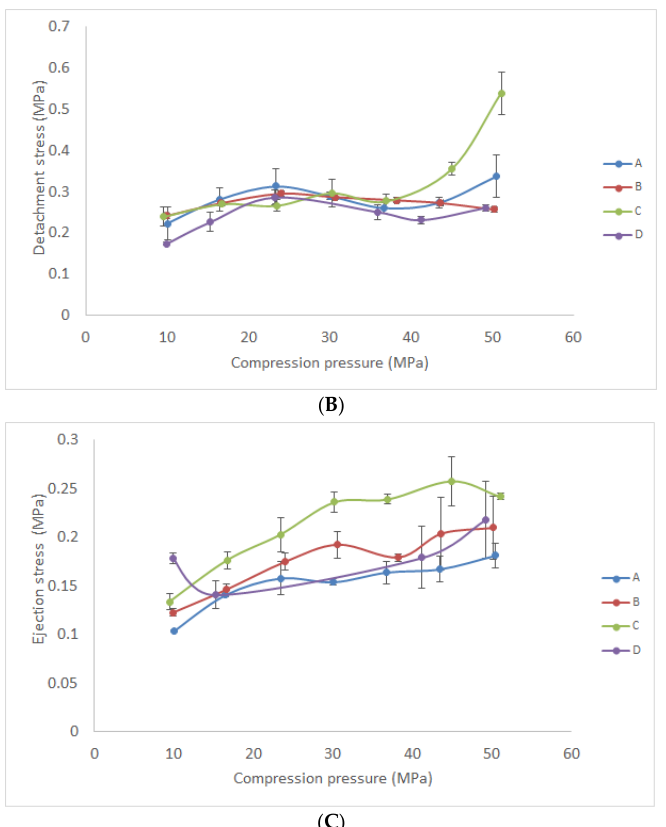
Figure 5. Tableting properties of the investigated materials compressed under different compres- sion pressures: ( A ) tensile strength; ( B ) detachment stress; ( C ) ejection stress. Table 6. The force of adhesion of tablets manufactured by direct compression of powders A–D. Sample A B C